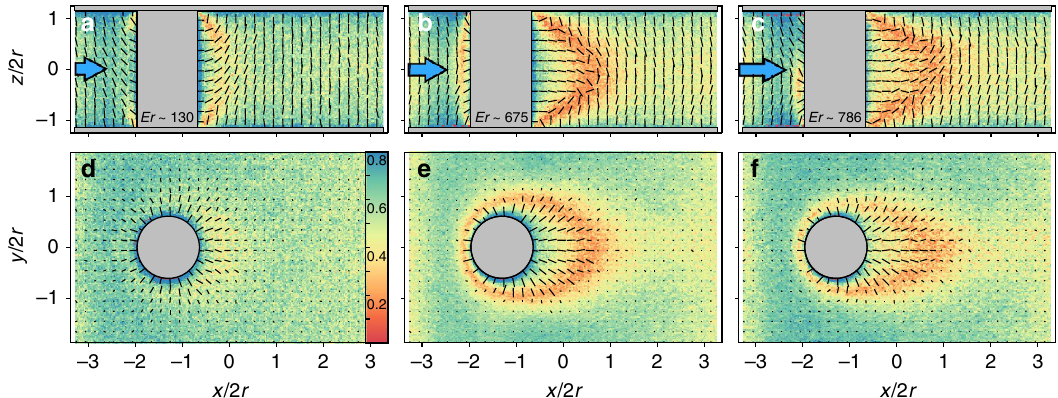
Figure 7 | Flow-induced local nematic order. ( a – c ) Magnitude of the local nematic order in the x–z plane located at y ¼ 0 (see attached colour bar). The cylindrical grey area represents the cylindrical pillar and the arrow above each plot indicates the direction of flow. Small dashes in the maps represent the local director field such that the length of a dash denotes its three-dimensional orientation: shorter dashes have an orientation closer to the normal to the plane of the map. The Ericksen numbers considered are ( a ) Er C 130, ( b ) Er C 675 and ( c ) Er C 786. ( d – f ) Corresponding director fields over the x–y plane located at z